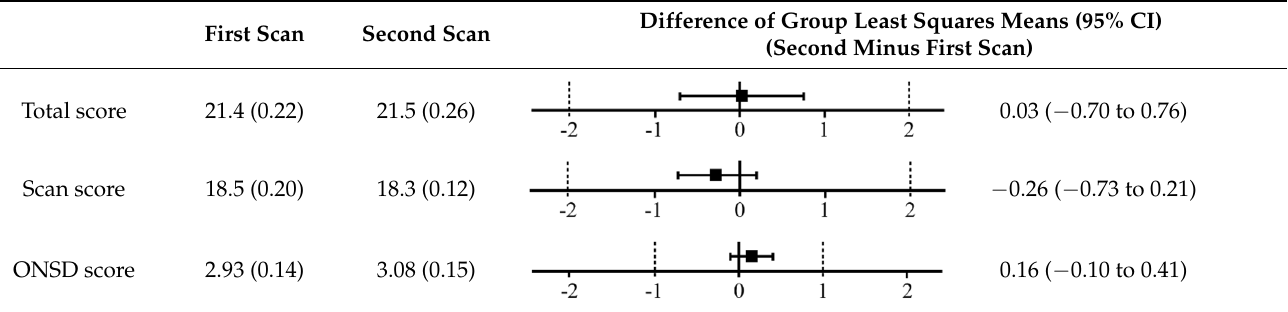
Table 3. The differences in ocular POCUS scores between the first and second scans.